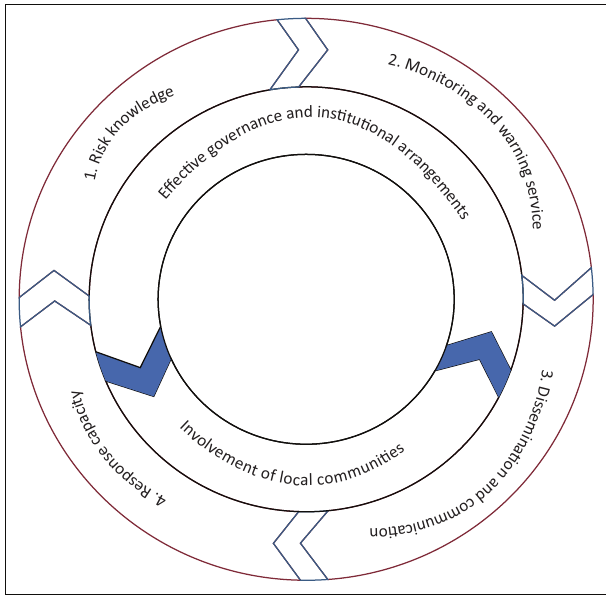
FIGURE 3: Conceptual framework for assessing community-based early warning systems. TABLE 2a: Four elements for developing a community-based early warning system. Risk knowledge